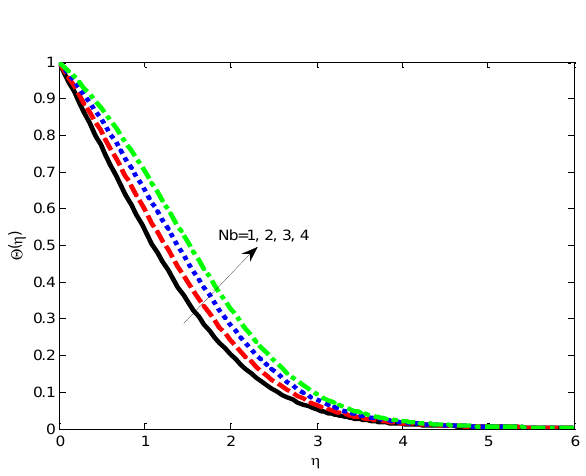
Figure 11. Effect of S on ( )  .